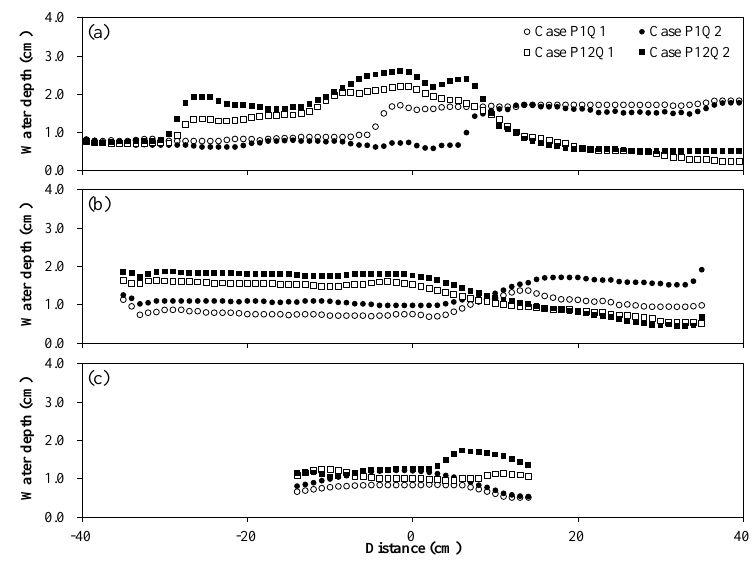
Figure 10. Comparison of the inundation depth by changing flowrate: ( a ) Sec. A; ( b ) Sec. B; ( c ) Sec. C.